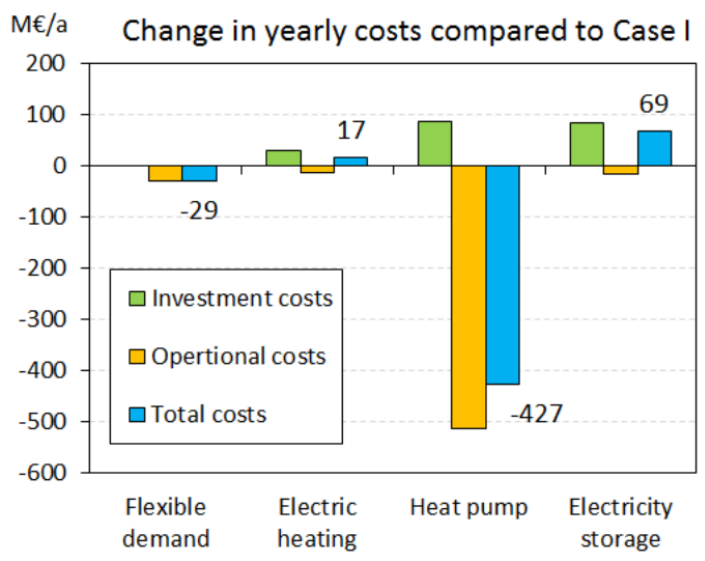
Figure 15. Changes in the annual costs of the Finnish energy system after employing 300 MW e flexibility (and additional storage if needed) compared to the case without flexibility (Case I). The costs are calculated with 5% interest rate and in